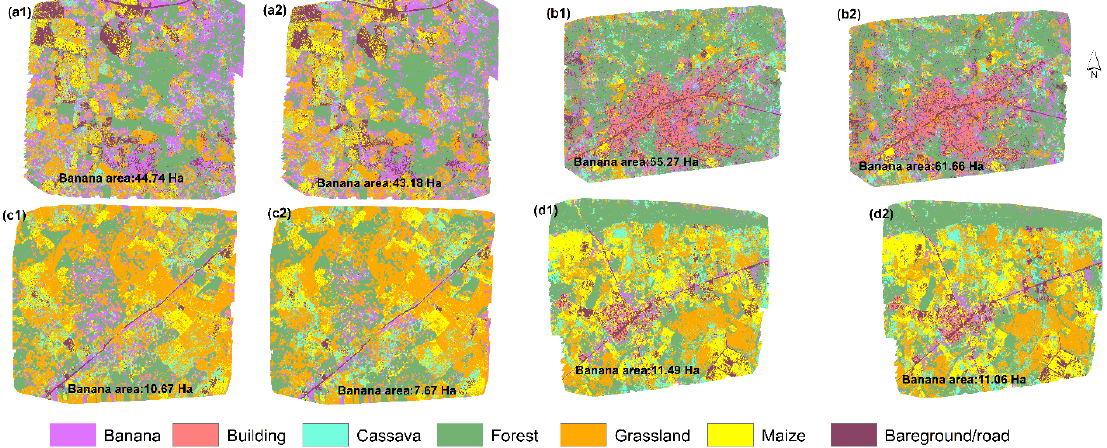
Figure 3. Model prediction maps for ( a ) Igbeji, ( b ) Olokuta, ( c ) Ipaja Road, and ( d ) Ipaja Town using Random Forest (1) and Support Vector Machine (2) at four UAV flight sites. The predicted banana crop area (ha) is indicated on the maps.